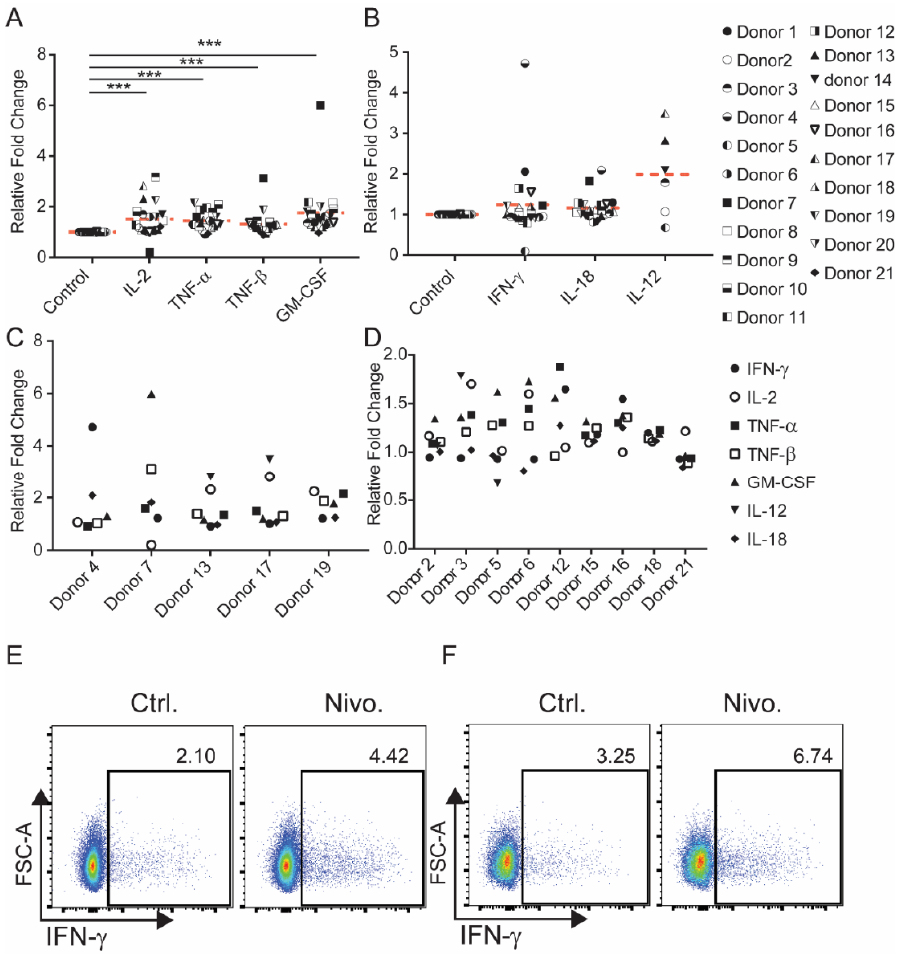
Figure 1. Induction of Th1-associated cytokine production by Nivolumab. ( A , B ) Frozen PBMCs from 21 healthy donors were thawed and cultured in RPMI1640 medium containing 5% AB human serum. Cells were then treated with Nivolumab (20 μ g/mL) in the presence of anti-CD3 mAb (0.1 μ g/mL) for three days. Cell supernatants were harvested and tested for cytokine production by Luminex analyses. ( C , D ) Data representing specific donors from Figure 1A are shown. ( C ) Donors whose PBMCs produced at least two cytokines at concentrations greater than two-fold than that of controls in response to Nivolumab treatment are shown. ( D ) Donors whose PBMCs did not produce any cytokines at least two-fold greater than those of the controls are shown. ( E , F ) Cell culture was performed as described in Figure 1A,B. Cells were harvested and intracellularly stained with fluorescence-conjugated IFN- γ for flow cytometric analysis. The expression of IFN- γ in CD4 + ( E ) and CD8 + ( F ) T cells are shown ( n = 10). *** p < 0.001.